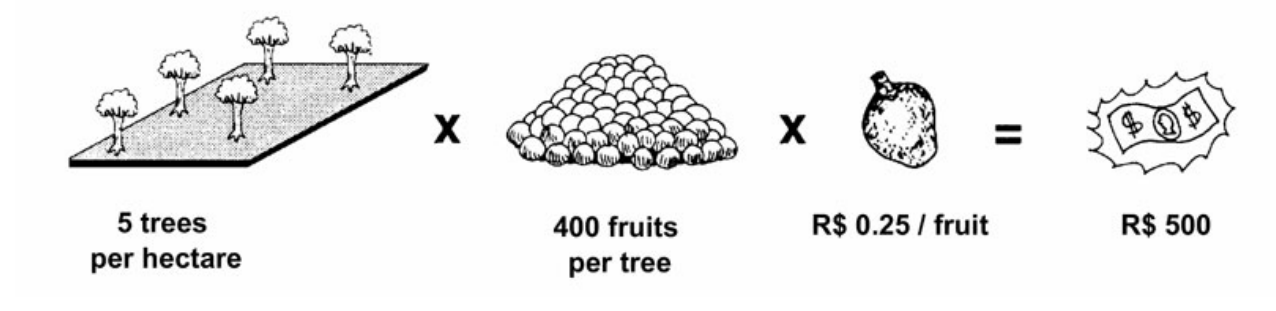
Fig. 4. Calculation of the value of fruit from 1 ha of forest. Source: Shanley and Medina